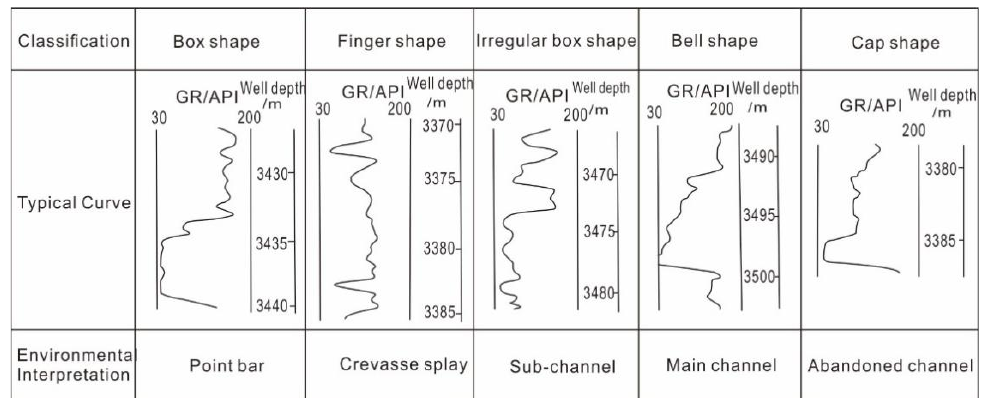
Figure 9. Core characterization and logging curve characteristics of well 10. By observing the logging curve and core, the Su-X block is mainly formed in a mean- dering river, and the sedimentary microfacies include a branch channel, crevasse splay, floodplain and swamp (Figure 10), which are consistent with previous studies. The log- ging curves of the different sedimentary microfacies were obviously different in shape, grading, thickness and amplitude. An abandoned channel is an important signal to iden- tify the boundary of a single channel. Based on amplitude and curve shape, its logging curve can be divided into two patterns: gradual transition interfaces and sudden transi- tion interfaces. The sudden transition interfaces are abandoned at high energy, while the